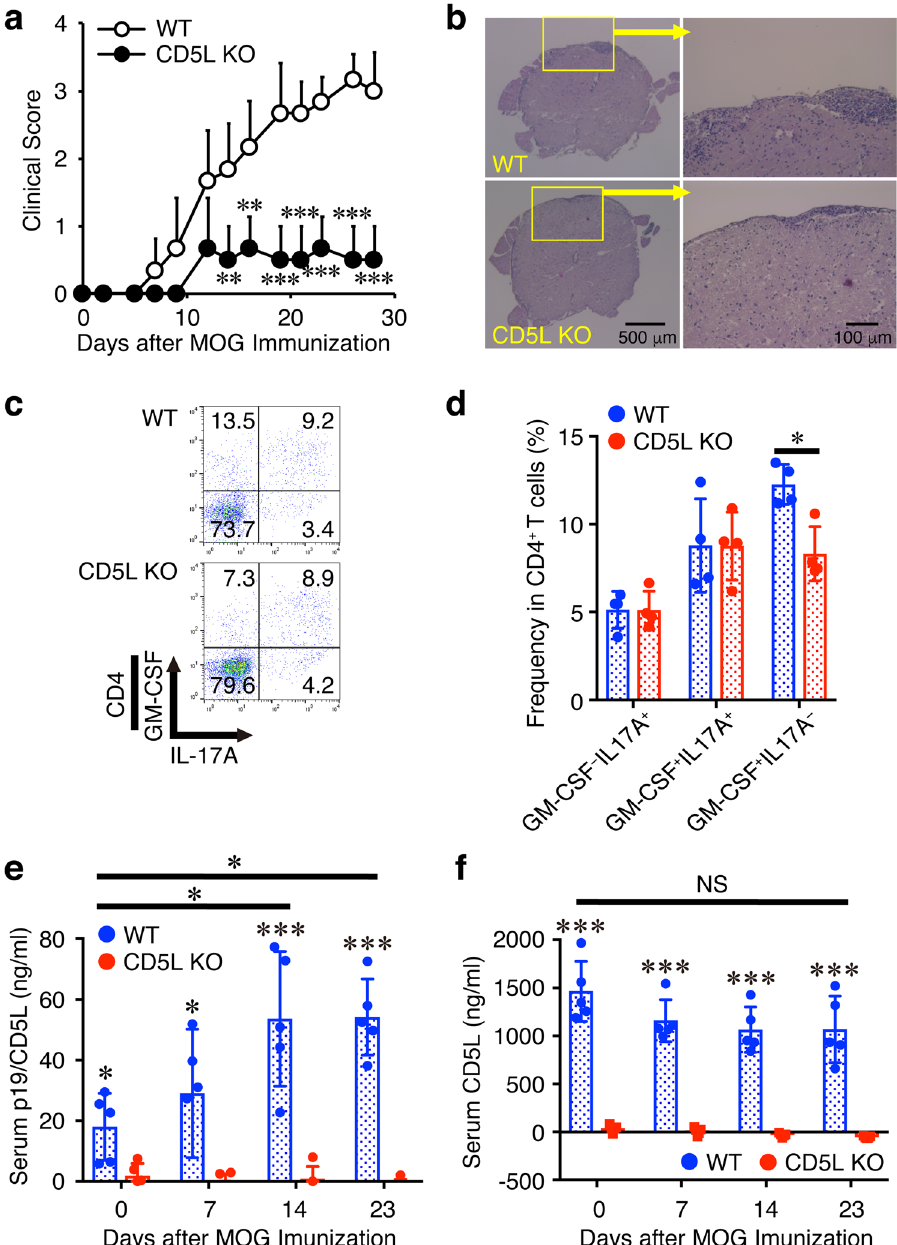
Figure 5. CD5L-deficient mice show alleviated EAE with reduced frequency of GM-CSF + CD4 + T cells in the CNS. ( a – d ) WT mice or CD5L-deficient mice were immunized with MOG 35-55 peptide and their clinical scores were monitored with time ( a ). On day 15, spinal cords and brains were harvested, and the CNS was histopathologically analyzed with H&E staining. Representative images are shown ( b ). Mononuclear cells were also isolated from the CNS, and intracellular cytokine staining was performed after restimulation with PMA and ionomycin. Representative dot plots of GM-CSF, and IL-17A in CD4 + T cells are shown ( c ). Average frequencies of respective CD4 + T cells were calculated and compared ( d ). Blood was also taken over time and serum levels of p19/CD5L and CD5L were determined by ELISA ( e , f ). Data are shown as mean ± SD (n = 4–6) and are representative of three independent experiments. P values were determined using unpaired, two-tailed Student’s t -test ( a , d ) or one-way ANOVA ( e , f ). * P < 0.05, ** P < 0.01, *** P < 0.001. NS, not